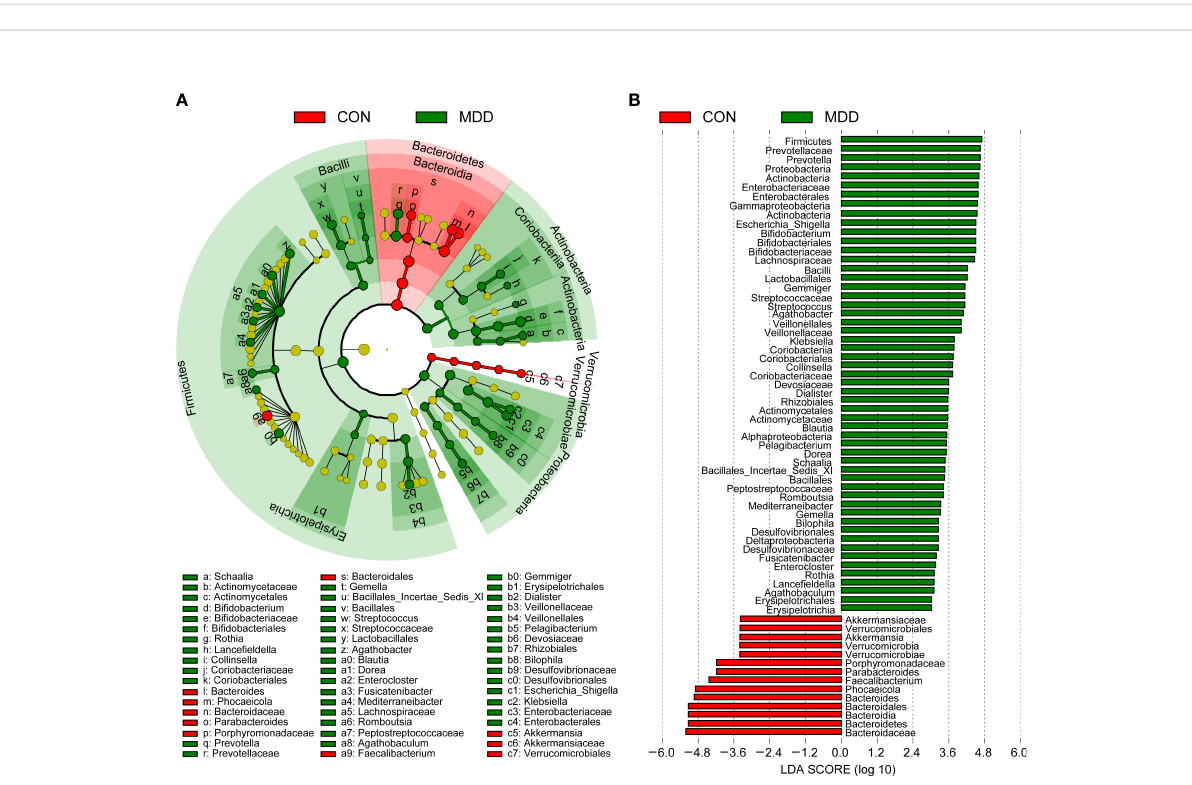
FIGURE 4 Taxonomic differences of the fecal microbiota between childhood MDD patients and the healthy controls. LEfSe identi fi ed the features of the fecal microbiota that are discriminative with respect to childhood depression using the LDA model results for the bacterial hierarchy (A) , while LDA coupled with effect size measurements identi fi ed the most differentially abundant taxa between the two groups (B) . Only the taxa meeting a signi fi cant LDA threshold value of > 3 are